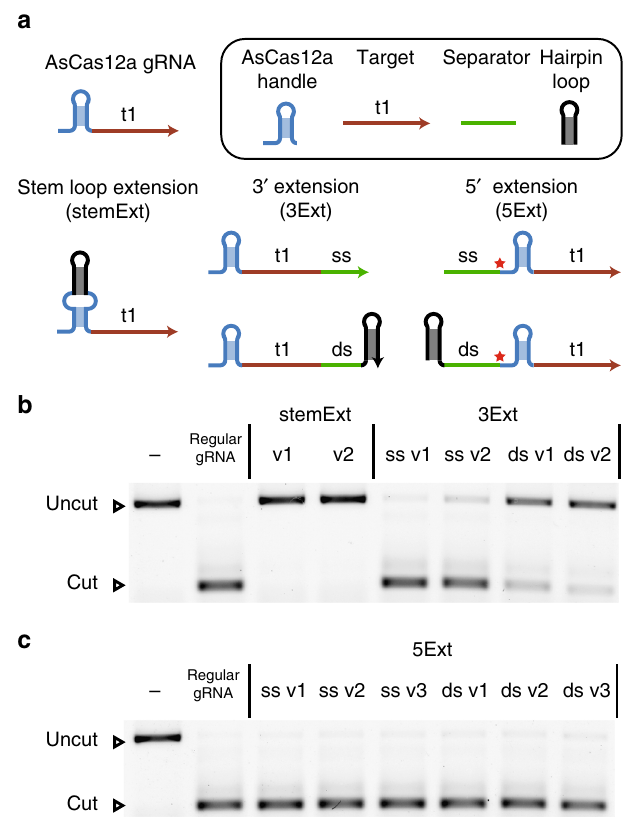
Fig. 1 Possibilities for extending Cas12a gRNAs. a The principal possibilities are extension of the stem (stemExt), extension at the 3 ′ end (3Ext), and extension at the 5 ′ end (5Ext). The extension of the stem is necessarily double stranded, while at the 3 ′ and 5 ′ end either a single-stranded (ss) extension or a (partially) double-stranded (ds) extension can be added. The red star for the 5 ′ extension marks the point where Cas12a cleaves a successfully bound gRNA. b Agarose gel of Cas12a cutting a fl uorescently labeled target DNA for different stemExt and 3Ext gRNAs with target sequence t1 (v1: version 1, uncut: 1190 bp, cut: 357 bp). c Agarose gel